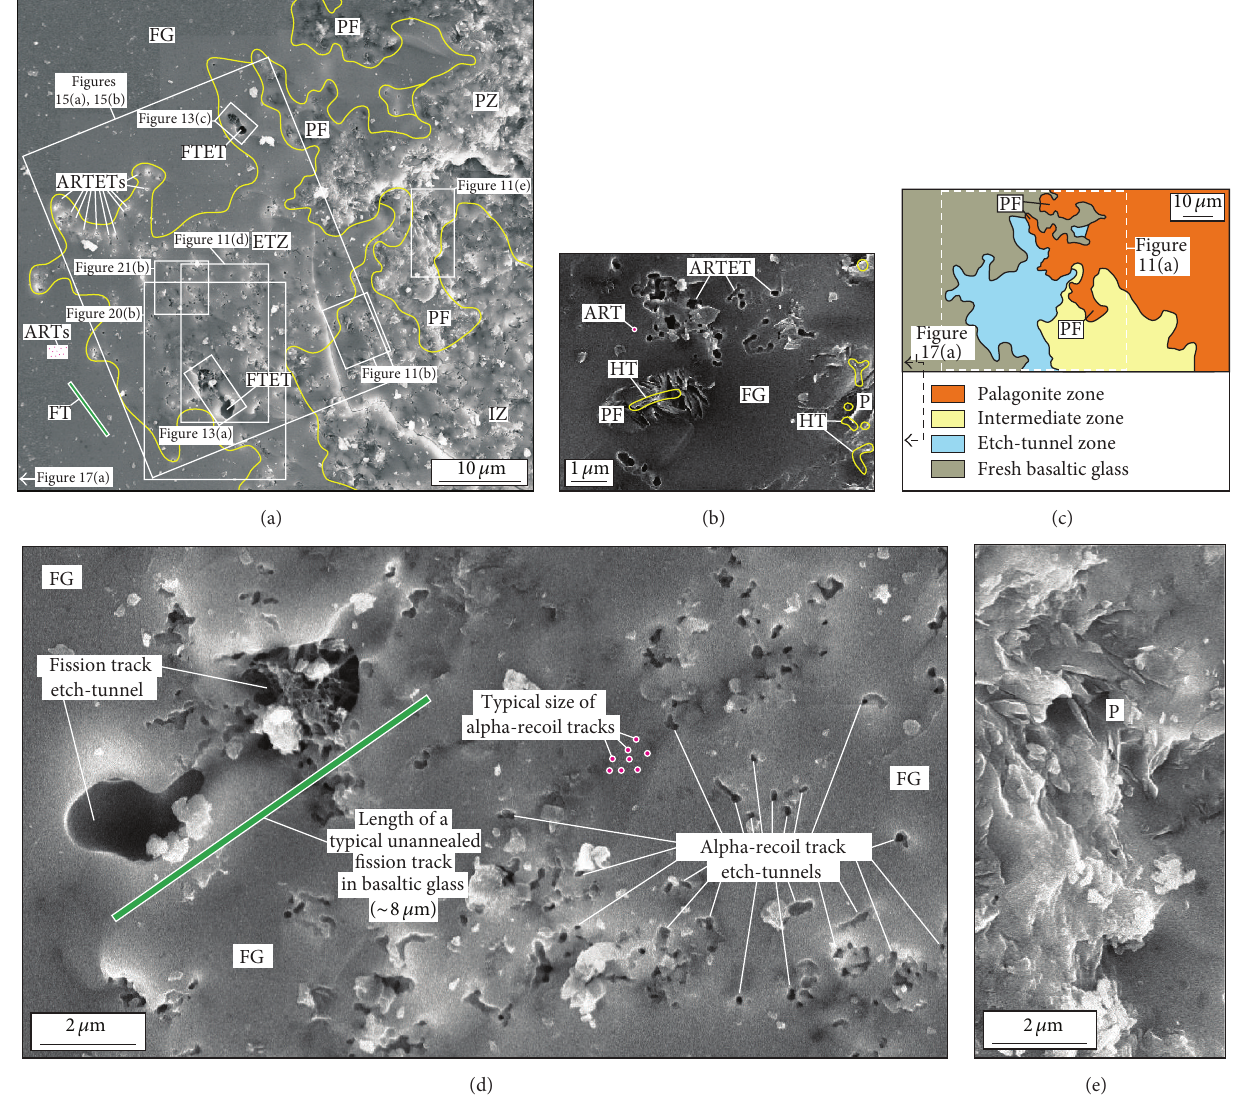
Figure 11: High resolution SEM mapping of the glass-palagonite interface and associated etch-tunnel zone (as observed on the freshly fractured surface of a basaltic glass “chip sample” of DSDP-418A-75-3[120–123] ). (a, b, d, and e) Secondary electron images. (a) Overview of a representative region of the glass-palagonite interface, highlighting four microtextural domains (boundaries shown as yellow lines; also see (c)) that include two large FTETs and several hundred smaller ARTETs. (b) Close-up from (a) highlighting where the palagonite zone is encroaching upon (overprinting) the etch-tunnel zone. (c) Alteration map, showing the distribution of the four microtextural domains outlined in (a). (d) Close-up (from (a)) of the etch-tunnel zone, highlighting one FTET and several ARTETs. Note the similarity in size between the hypothetical fission track (green bar) and the FTET and between the hypothetical ARTs (pink dots) and the ARTETs. (e) Representative close-up (from (a)) of the palagonite zone. ARTs: alpha-recoil tracks; ARTETs: alpha-recoil track etch-tunnels; ETZ: etch- tunnel zone; FG: fresh basaltic glass; FT: fission track; FTET: fission track etch-tunnel; HT: hypothetical preexisting alpha-recoil track etch- tunnel; IZ: intermediate zone (between the ETZ and the PZ); P: palagonite; PZ: palagonite